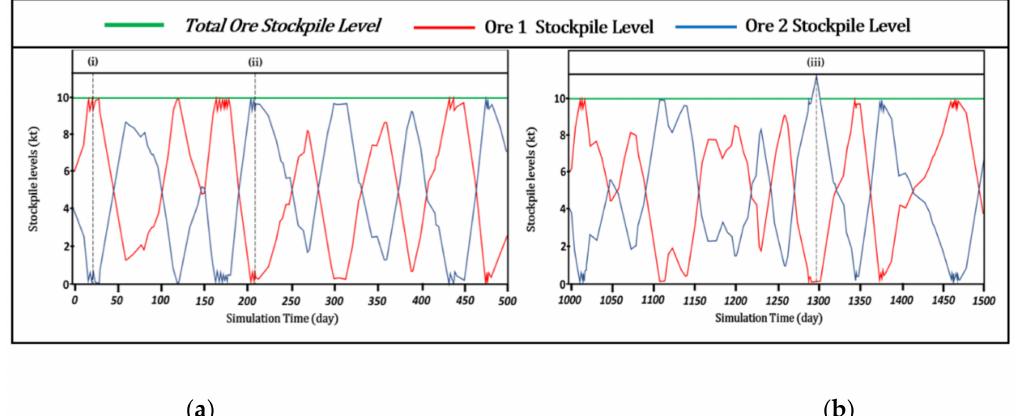
Figure 7. ( a ): Stockpile evolution during simulations with control parameters set at 10,000 t for the Target Ore Stockpile Level (TOSL) and 2000 t for the Critical Stockpile Level, (i) Cyclical jagged saw-tooth pattern showing the alternation between Mode A and Mode A Contingency. (ii) Cyclical jagged saw-tooth pattern showing the alternation between Mode B and Mode B Contingency. ( b ) (iii) System entering in Mode B Mine Surging, wherein the level of ore 2 type (low CN consuming ore) increases above the total ore stockpile target level to provide feed directly to the plant in response to a sustained stockout of the other ore type. Table 3. Summary of discrete event simulation throughputs and cyanide consumption results. Target Stockpile